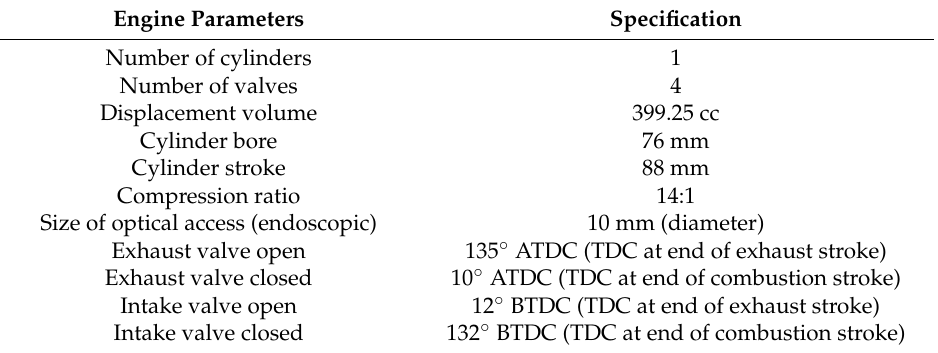
Table 1. Basic engine specification.